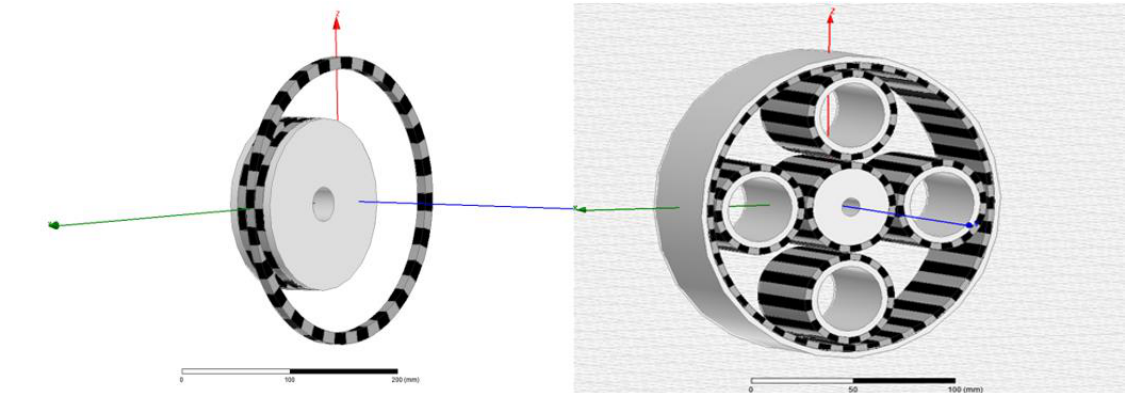
Figure 1. ( Left ) 1:2 Magnetic Spur Gear, maximum torque: 24.2 Nm. ( Right ) 1:5 Magnetic Spur Gear, maximum torque: 32 Nm.